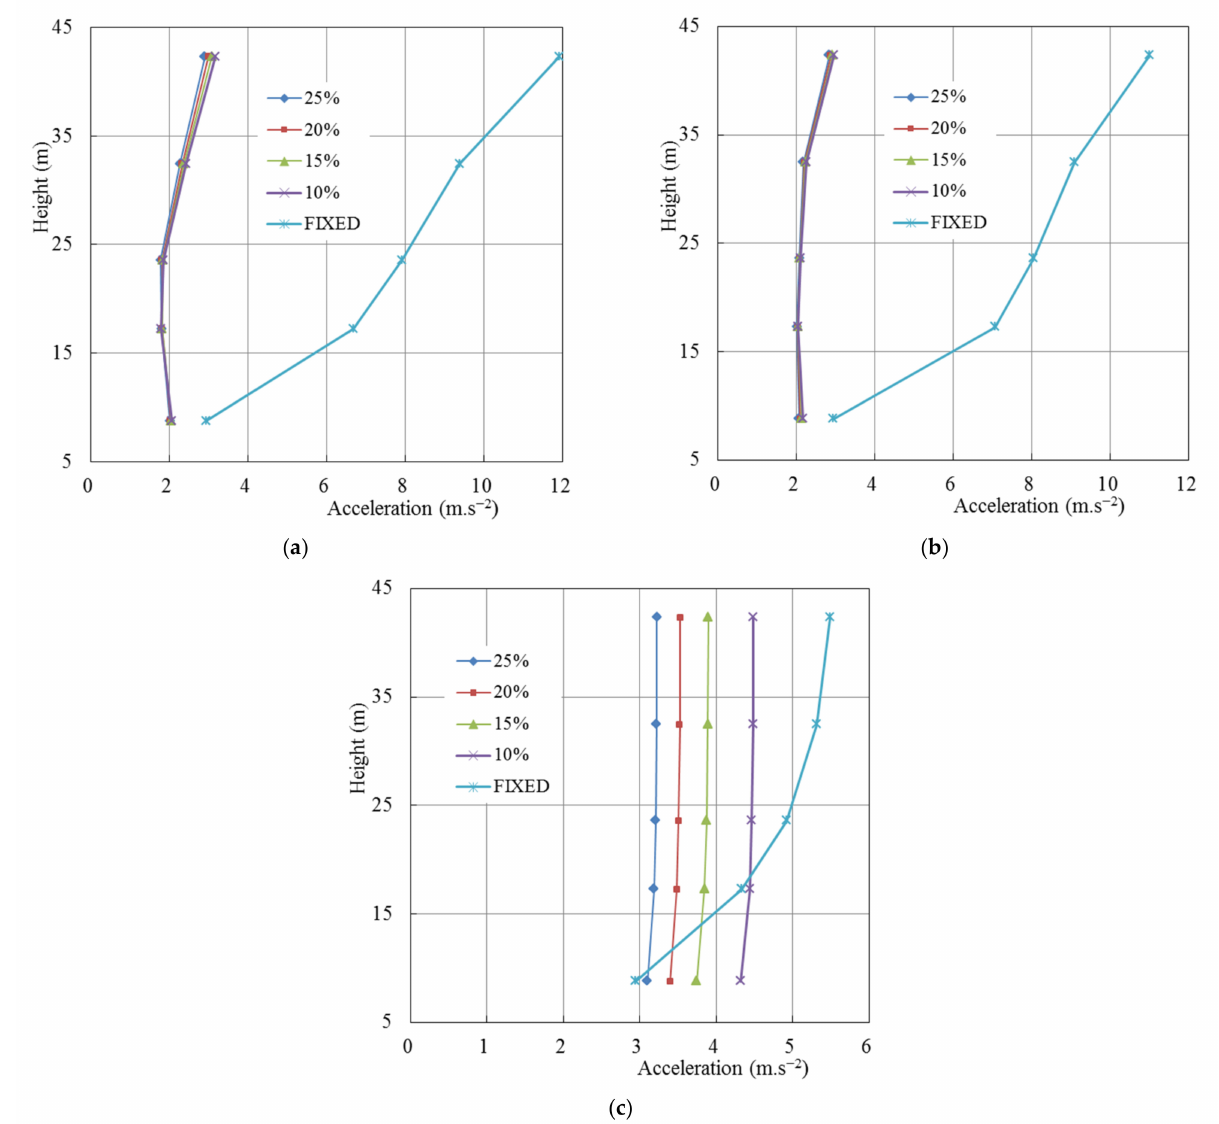
Figure 12. Comparison of the peak acceleration response of the internal structure. ( a ) In the horizontal direction X ; ( b ) In the horizontal direction Y ; ( c ) In the vertical direction Z